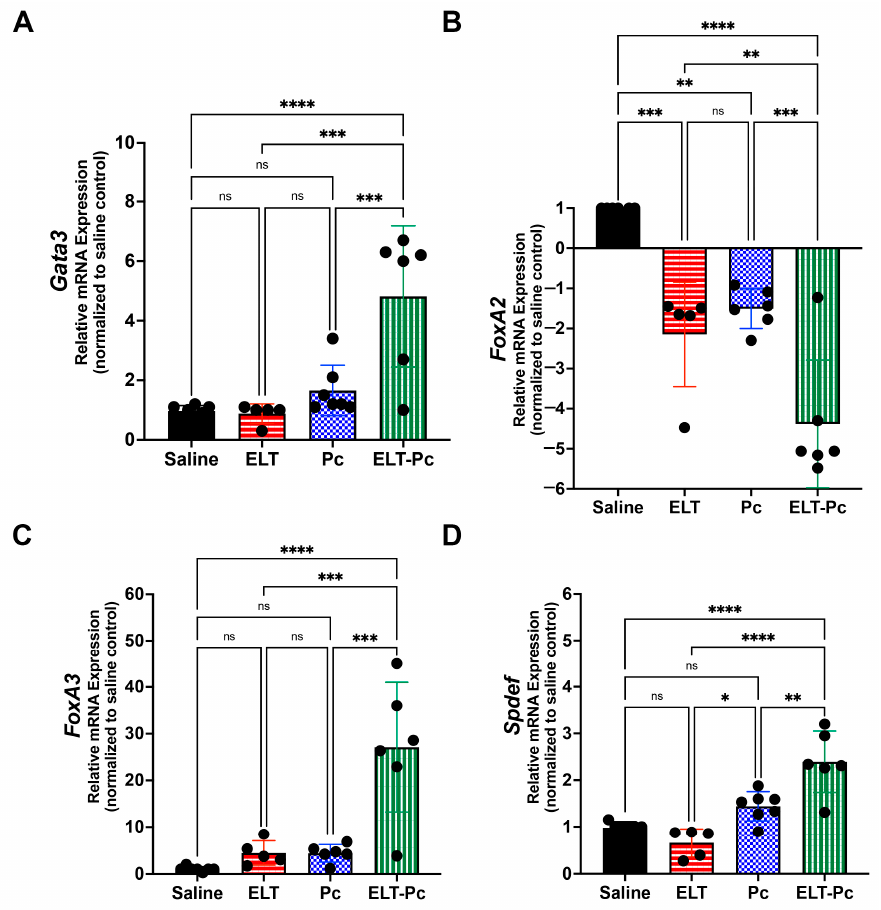
Figure 6. Evaluation of the expression level of STAT6-dependent transcription factor in the elastase-induced COPD animal model infected with Pneumocystis . mRNA levels of ( A ) Gata3 , ( B ) FoxA2 , ( C ) FoxA3 and ( D ) Spdef were evaluated by qPCR. Data were determined using the 2 − DDCt method, actin levels as internal control and normalized to saline control animal group. Data are expressed as mean ± SD and analyzed by ANOVA. ns = nonsignificant; * = p < 0.05; ** = p < 0.01; *** = p < 0.001; **** = p < 0.0001.